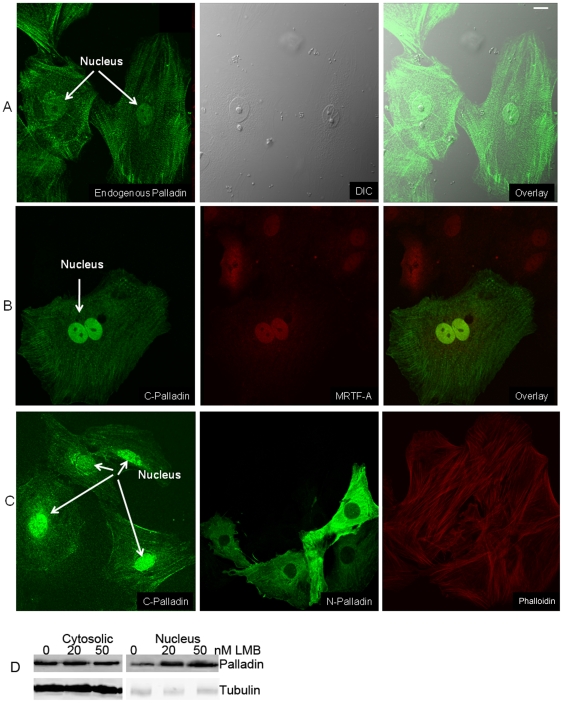
Confocal images demonstrating nuclear localization of full length endogenous palladin and of C terminal but not N terminal palladin.A) Endogenous palladin was detected in nuclei of mature SMCs (rat aortic SMCs). Cultured subconfluent R518 cells were fixed with cold methanol and stained with a palladin polyclonal antibody, and with Alexa fluor conjugated secondary anti-rabbit antibody. Inset shows the Western blot results of palladin in a nuclear fraction. B) Carboxyl (C) terminus of palladin co-localizes with MRTF-A in the nucleus. Rat aortic SMCs were transfected with myc tagged C-terminus of palladin. The C-terminus of palladin was detected with an anti-myc epitope antibody, and the endogenous MRTF-A was detected with an anti-MRTF antibody and secondary Alexa fluor conjugated anti-rabbit antibody. C) Expressed carboxyl (C) terminus but not amino (N) terminus of palladin localizes in the nucleus of R518 cells. Myc tagged N- or C- terminal palladin constructs were transfected into cultured R518 cells by electroporation. Cells were fixed after 72 h transfection, and proteins were detected with myc antibody. Secondary antibody labeling alone, under identical conditions showed no detectable fluorescence. Scale bar, 10 µm. D) endogenous palladin was accumulated in the nucleus by leptomycin B (LMB). Cultured subconfluent R518 cells were trypsinized and subjected to nucleus-cytosolic fractionation. Equal amounts of protein were loaded for Western bloting. Leptomycin B 20 and 50 nM increased the palladin expression level in the nucleus fraction. Tubulin was used as a marker for the cytosolic fraction.